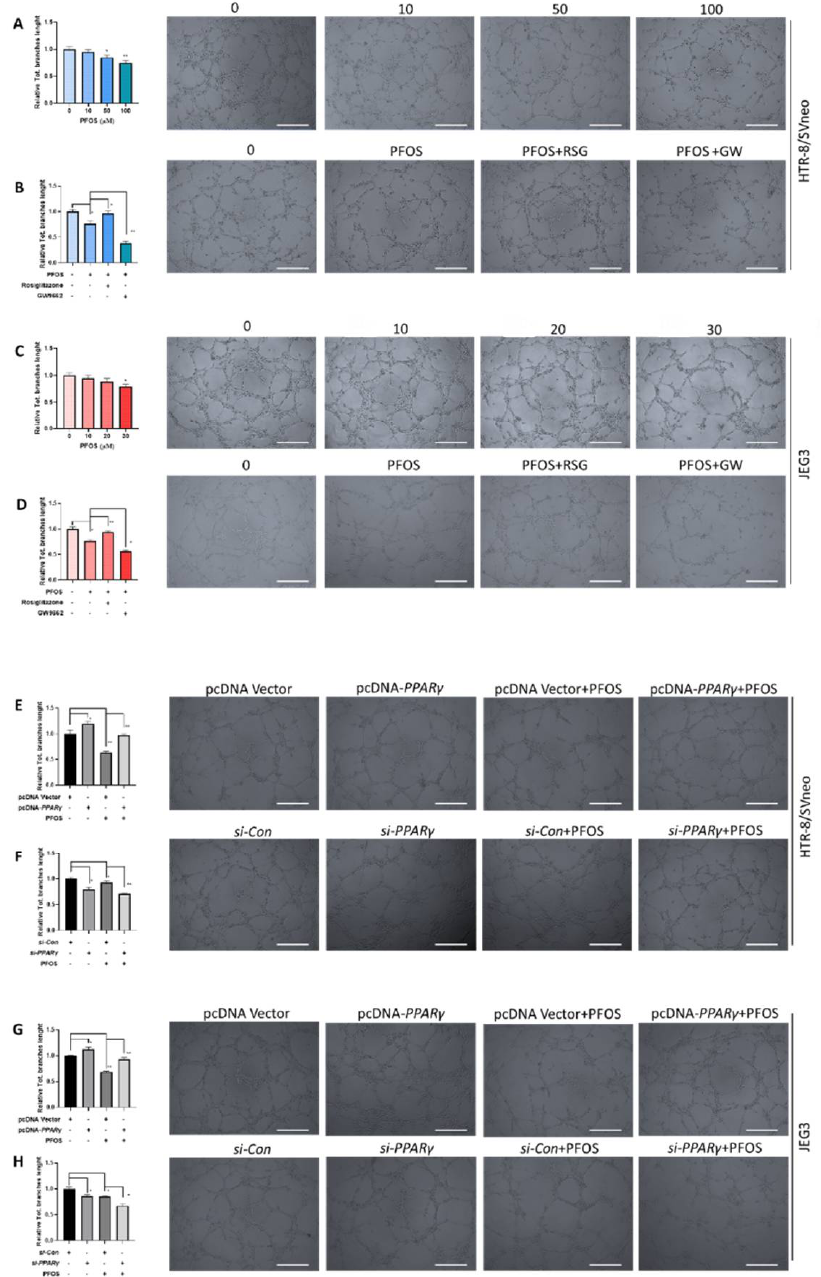
Figure 3. Effect of PPARγ on angiogenesis exposed to PFOS in vitro. The branches length was measured in HTR-8/SVneo and JEG-3 cells exposed to PFOS for 24 h ( A , C ), in the absence or presence of rosiglitazone and GW9662 ( B , D ), with PPAR γ overexpression ( E , G ) and knocking down ( F , H ) in HTR-8/SVneo and JEG-3 cells (Scale bar: 200 µ m). The data are shown as the means ± S.E.M. * p < 0.05; ** p < 0.01; compared with the indicated group, n =